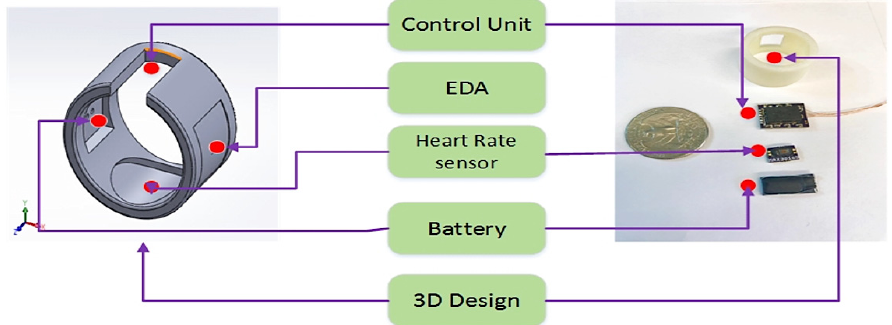
Figure 13. Structure of the wearable system proposed in [47]: 3D model of SensorRing (left side) and disassembled device with support and cover (right side of the image) (Reprinted with permission from ref. [47]. Copyright 2021 IEEE).